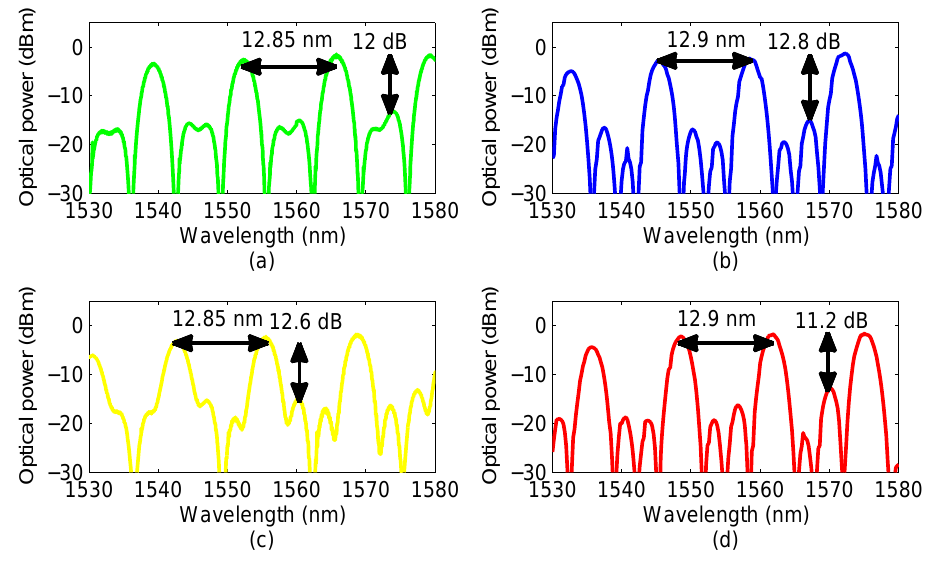
Figure 11. Normalized transmission response of the four optical output channels ( a ) ch-1 , ( b ) ch-2 , ( c ) ch-3 and ( d ) ch-4 .